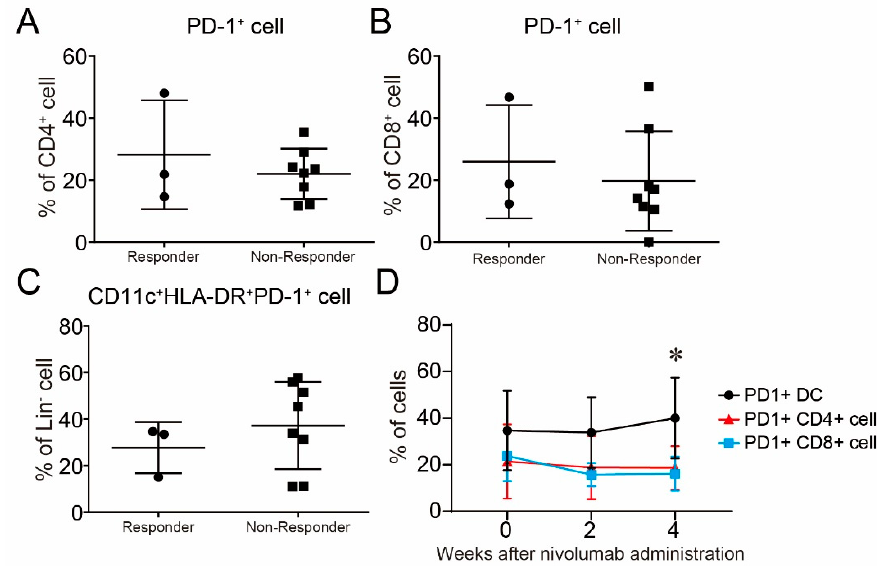
Figure 4. PD-1 expression on immune cells in peripheral blood in patients with melanoma. ( A–C ) PD-1 expression in ( A ) CD4 + cells, ( B ) CD8 + cells, and ( C ) dendritic cells (DCs) was evaluated in patients with melanoma by FACS analysis to compare the difference between responders and non-responders to nivolumab. ( D ) The time course of PD-1 expression on CD4 + cells, CD8 + cells, and DCs in all melanoma patients during nivolumab treatment. Results are expressed as the mean ± SE. All p -values were obtained by Student’s t test: *, p < 0.05.